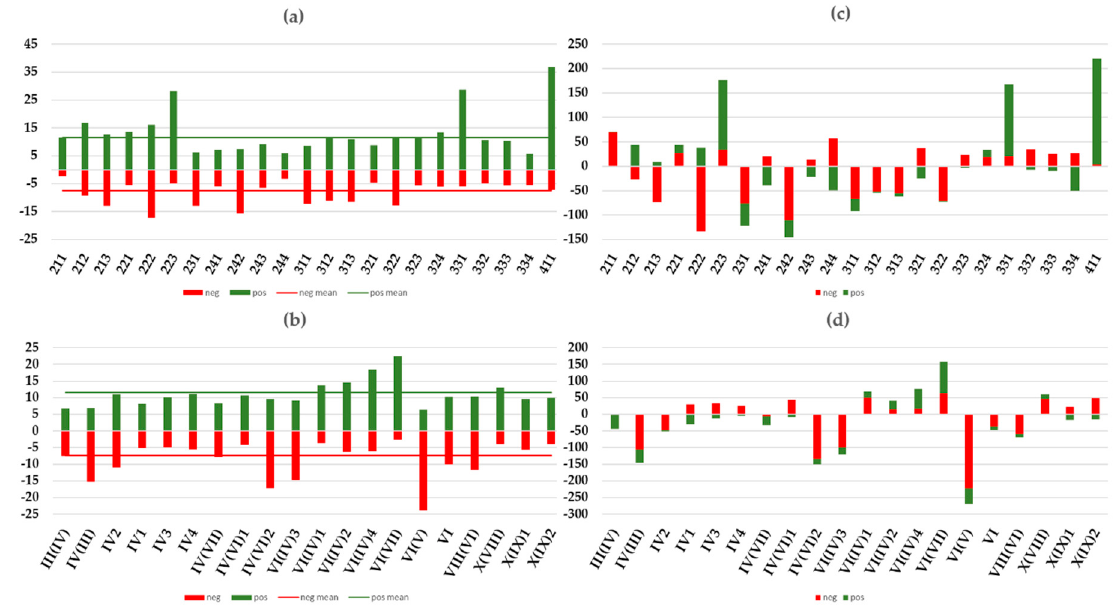
Figure 8. Percentage of pixels with a significant trend by CORINE Land-Cover class ( a ) and by phytoclimatic type ( b ). Negative is represented by negative (in red color) and positive is green in color. Lines are mean values. Difference in percentage ( y -axis) between the observed and expected negative NDVI, with negative (in red color) and positive (in green color) short-term trend pixels from our study area by CORINE Land-Cover class ( c ) and by phytoclimatic type ( d ).